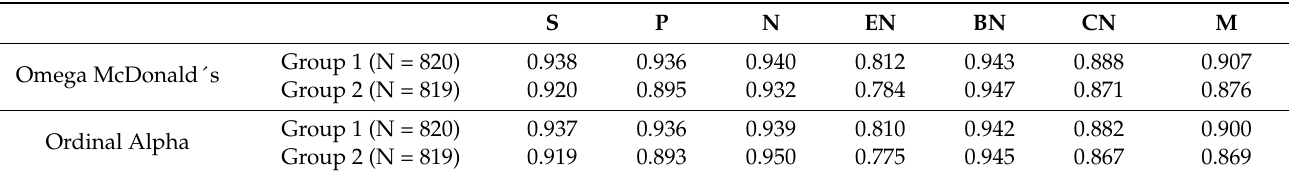
Table 4. Coefficients of McDonald’s omega and ordinal alpha for factors and